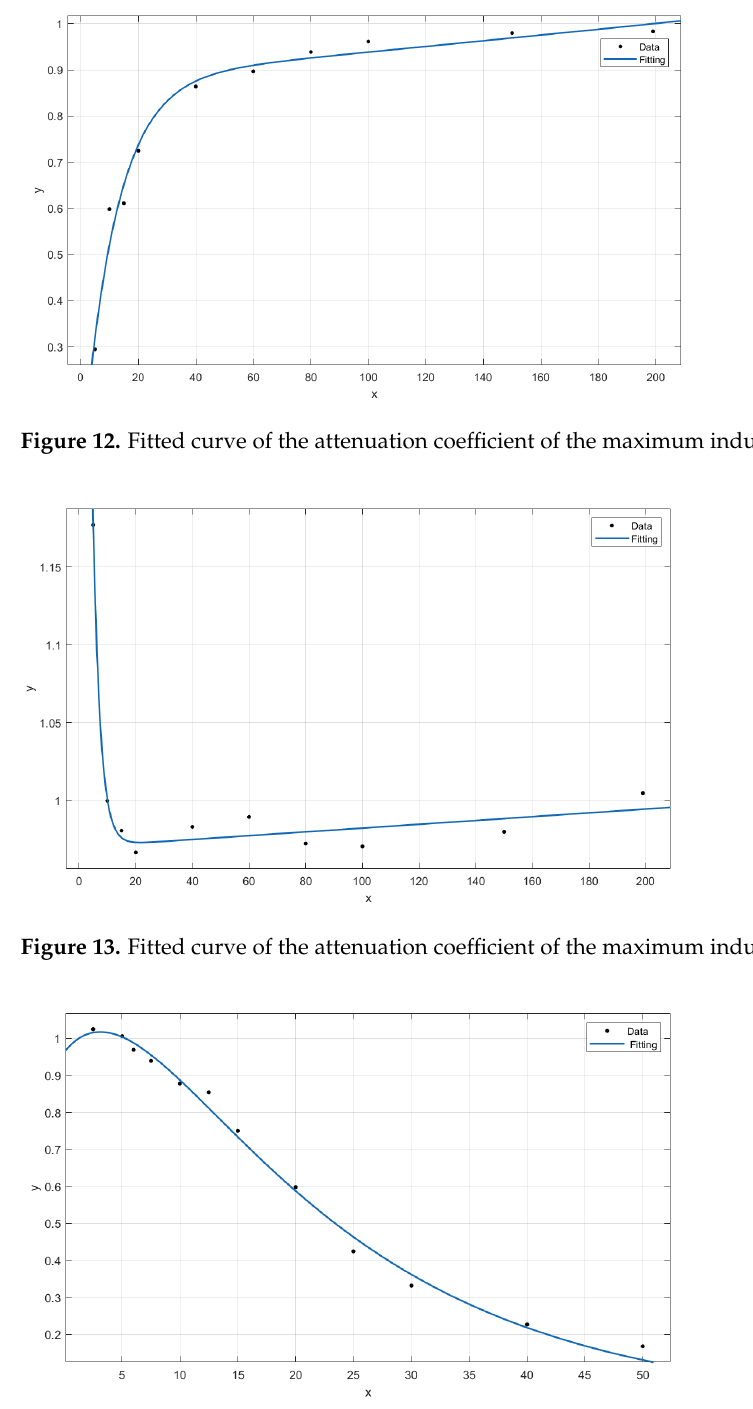
Figure 14. Fitted curve of the attenuation coefficient of the maximum induced voltage—Case